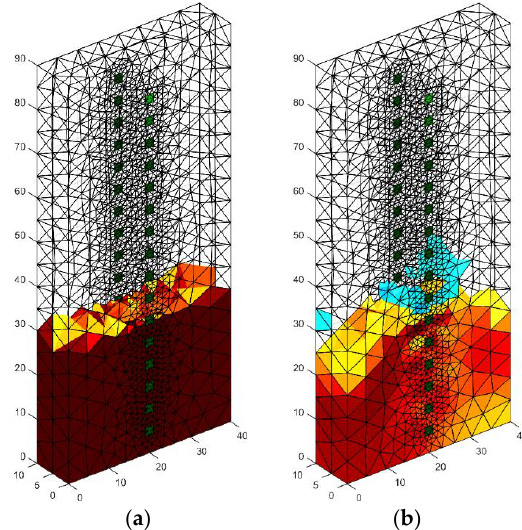
Figure 10. The geometrical model 3D with 2 × 16 electrodes—the image reconstruction: ( a ) pattern model, ( b ) reconstruction created with the use of Gauss-Newton method with Laplace regularization.